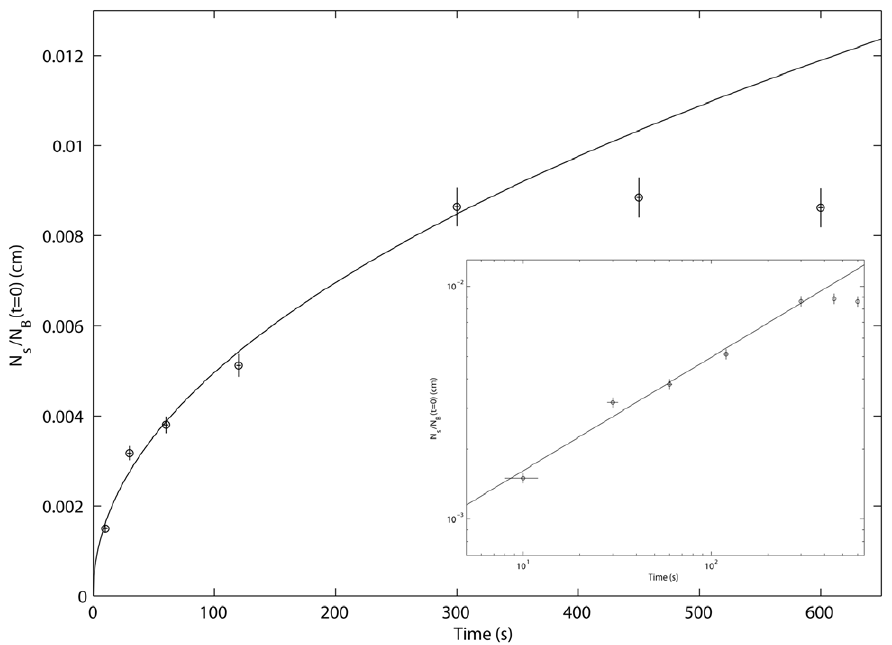
Figure 3. Deposition rate of a Tm on p-Lys substrate shows the process is diffusion driven and irreversible. The number ratio between a Tm molecules adhered to p-Lys coated mica and in 1 cm 3 of the bulk solution, N s /N B (t=0) , increased with incubation time up to 300 s, as shown in both linear (main graph) and logarithmic (inset) scales. 5% of total number of a Tm molecules in the bulk solution were deposited on the substrate by the 300 s incubation; the absence of discernible change at longer incubation times of 450 s and 600 s suggests the top layer of the bulk solution was depleted of a Tm molecules [26]. Fitting data from incubation time 10 s to 300 s to Eq. 1 (solid lines) returned estimates of two parameters: exponent parameter p equals 0.49, in close accordance to an irreversible and diffusion driven deposition process [26]; and diffusion constant parameter D of